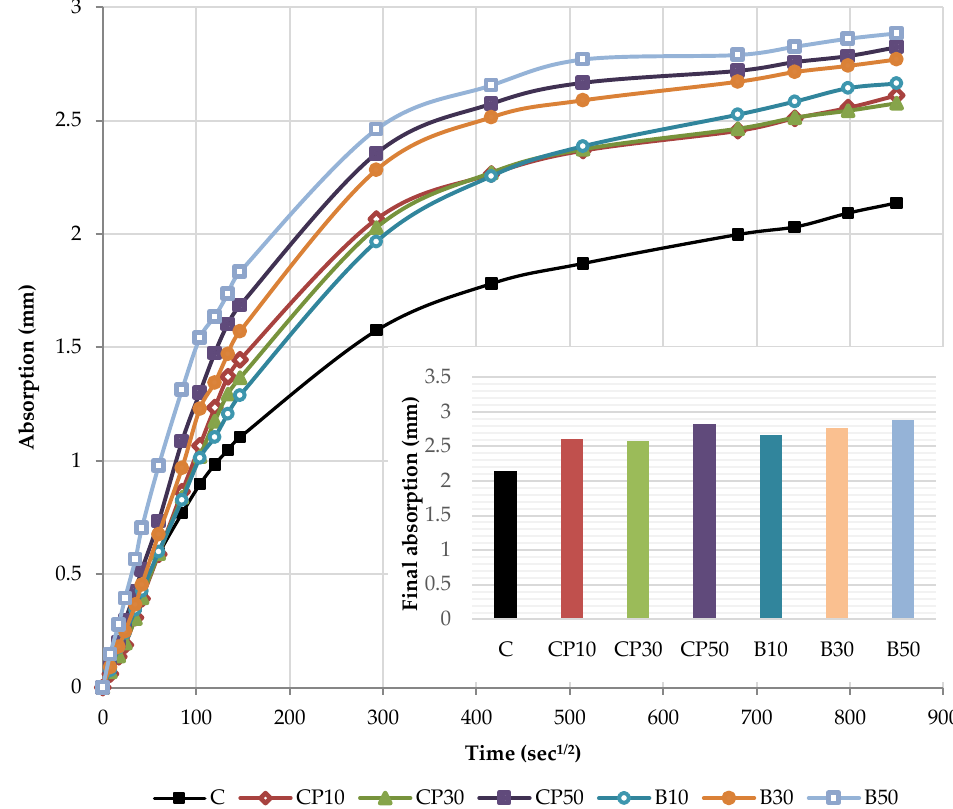
Figure 8. Capillary water absorption: the kinetics and the final values.